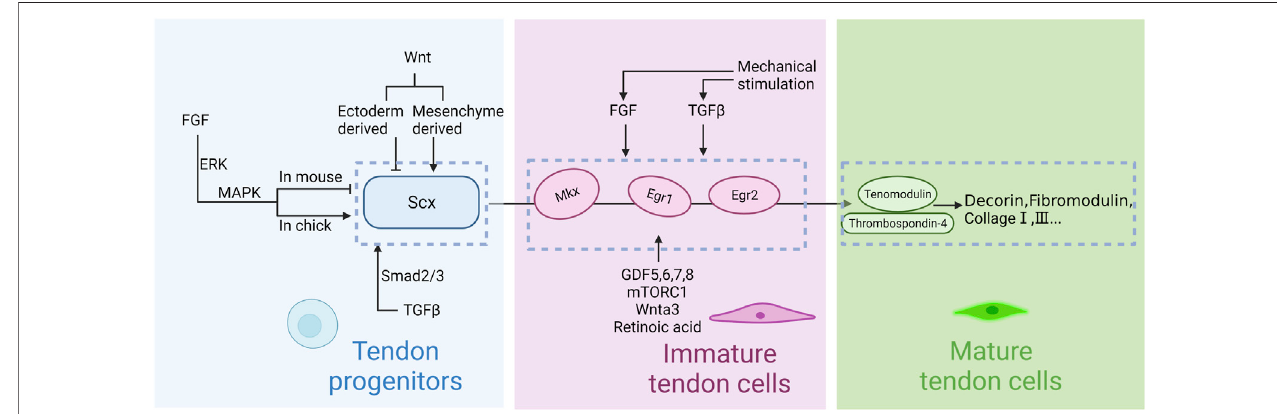
FIGURE 3 | Regulation of tendon development in embryogenesis. Scleraxis (Scx) is the fi rst signaling molecule implicated in tendon progenitor cell initiation, whereas Mohawk (Mkx) and early growth response 1 and 2 (Egr1, Erg2) are secondary signals for tendon differentiation and maturation. Thrombospondins (Thbs) and tenomodulin (Tnmd) are upstream factors which regulate collagen and matrix. FGF, TGF β and Wnt signaling pathways regulate the induction of Scx. GDF5,6,7,8, mTORC1andWnta3regulatetheupstreamtranscriptionfactors.MechanicalstimulationisinvolvedinregulationviatheTGF β andFGFsignalingpathway.Notably, the effects of FGF on chicken embryo and mouse embryo appear to be opposite. Mesenchymal progenitors are maintained by ectodermal Wnts and repressed by mesenchymal